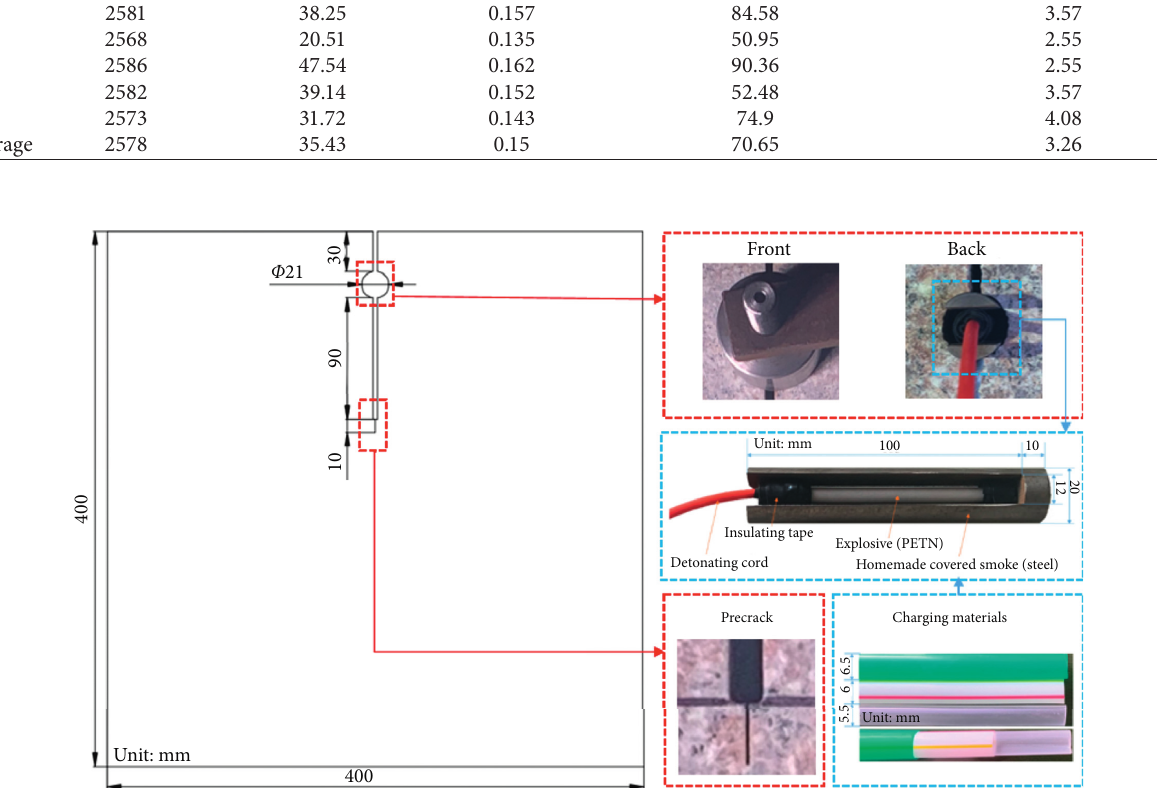
Figure 2: Schematic drawing of the GRPC and charging method (unit: